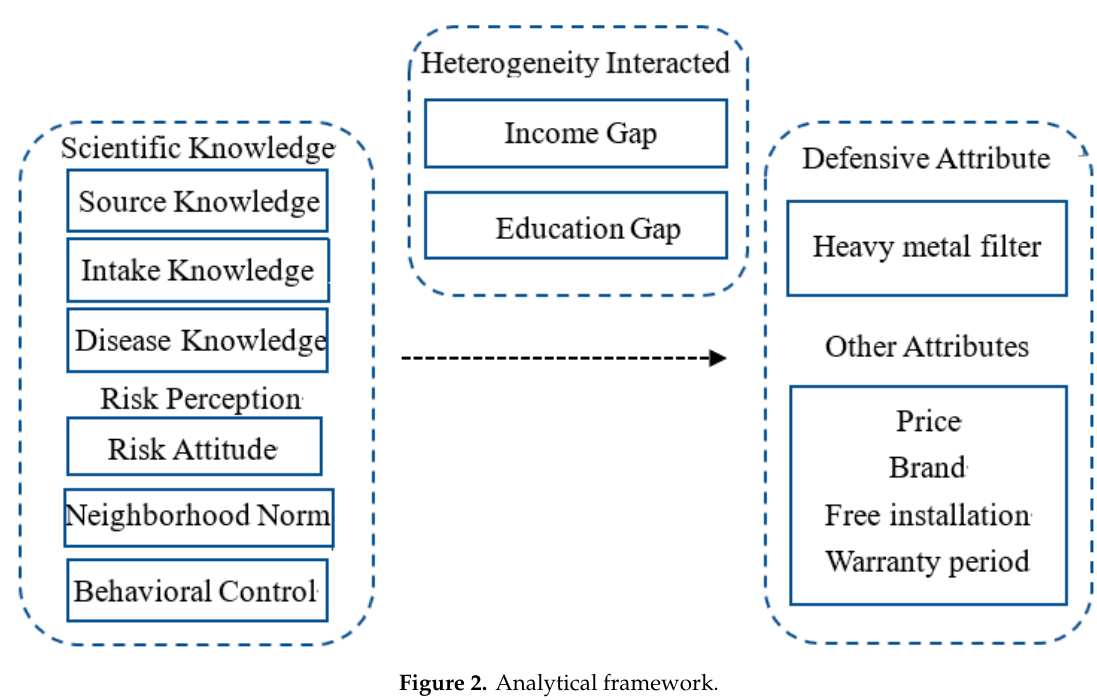
Figure 2. Analytical